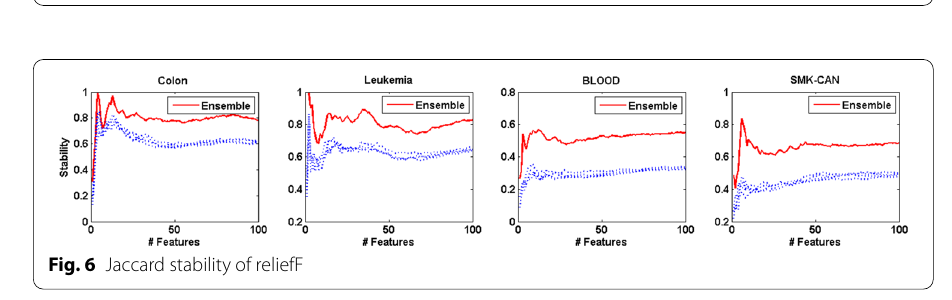
Fig. 5 Jaccard stability of information gain